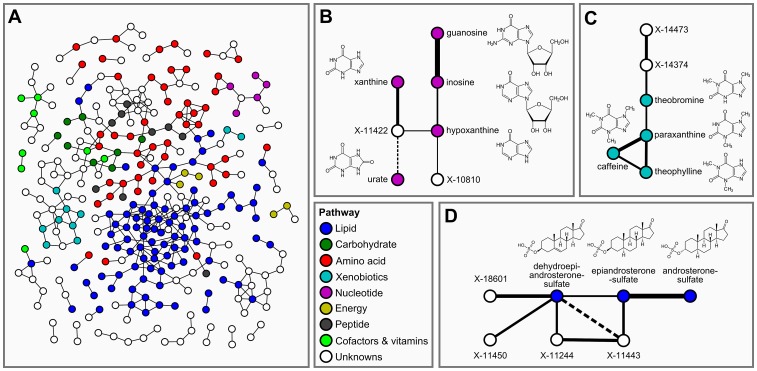
Gaussian graphical modeling.GGMs embed unknown metabolites into their biochemical context. A: Complete network presentation of partial correlations that are significantly different from zero at α = 0.05 after Bonferroni correction. The unknown metabolites are spread over the entire network and are involved in various metabolic pathways. B–D: Selected high-scoring sub-networks. We observe that GGM edges directly correspond to chemical reactions which alter specific chemical groups (e.g. carbonyl groups and methyl groups). Solid lines denote positive partial correlation. Dashed lines indicate negative partial correlations. Line widths represent partial correlation strengths.